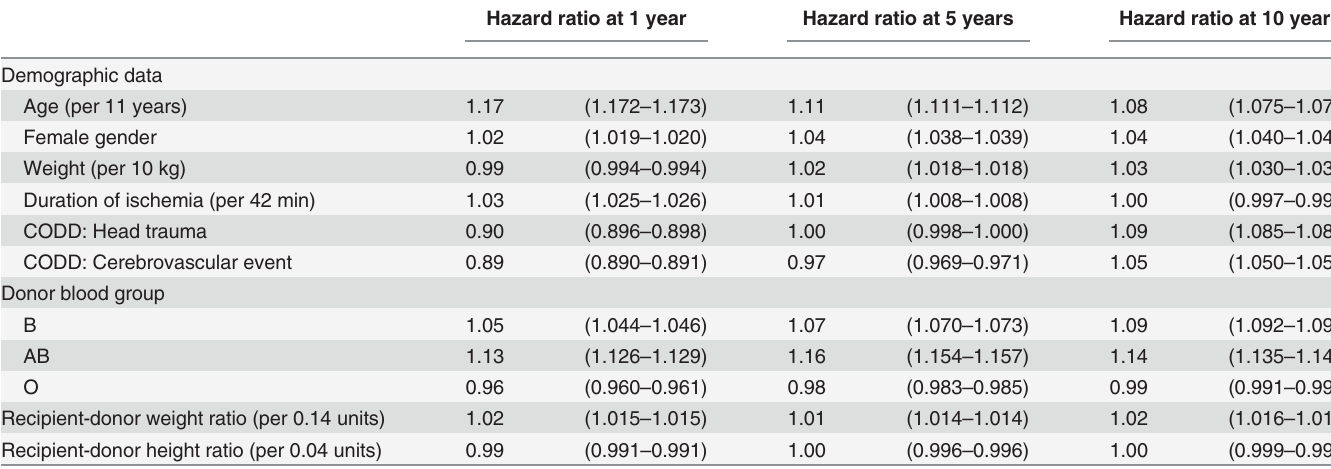
Table 4. Time-dependent hazard ratios for the 11 donor risk variables included in the IHTSA model.